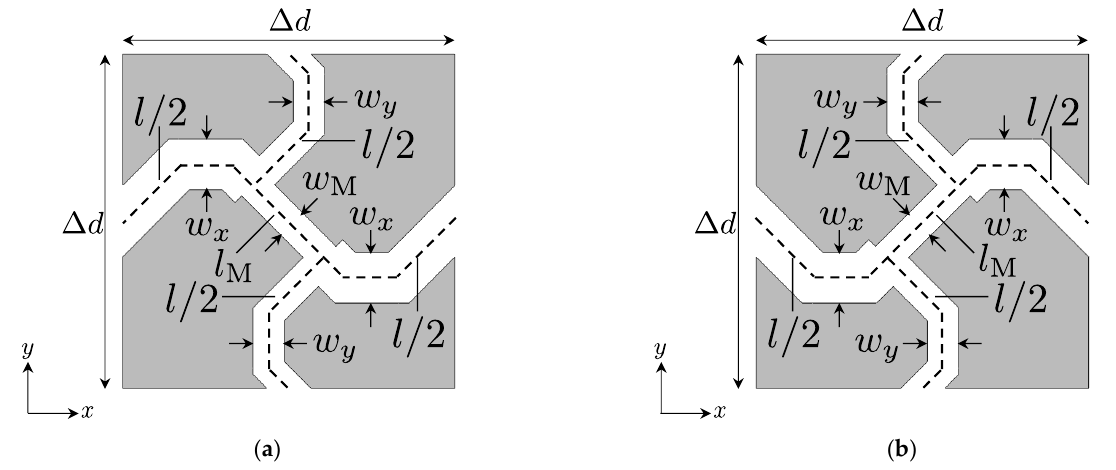
Figure 3. 2-D acoustic waveguide unit cell structures for realizing full-tensor anisotropic acoustic metamaterials. ( a ) ρ xx < 0 case; ( b ) ρ xx > 0 case. The waveguides are formed in the rigid body and are filled with the air.